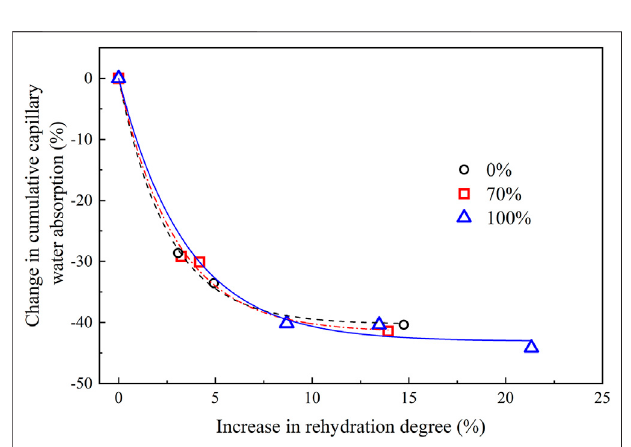
FIGURE 15 | Relationship between the cumulative capillary water absorption of UHPC-2 and its rehydration